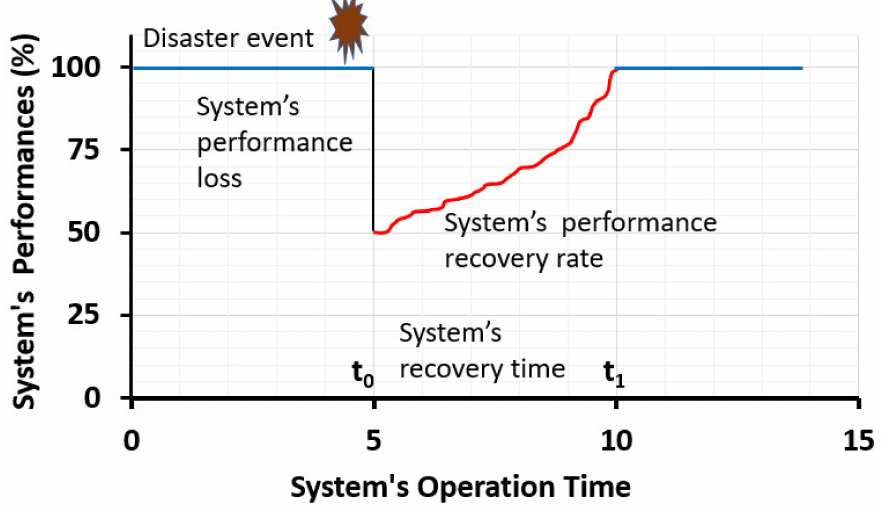
Figure 1. Measure of resilience (modified from Bruneau et al. [32]). The numbers in the x-axis are used only for